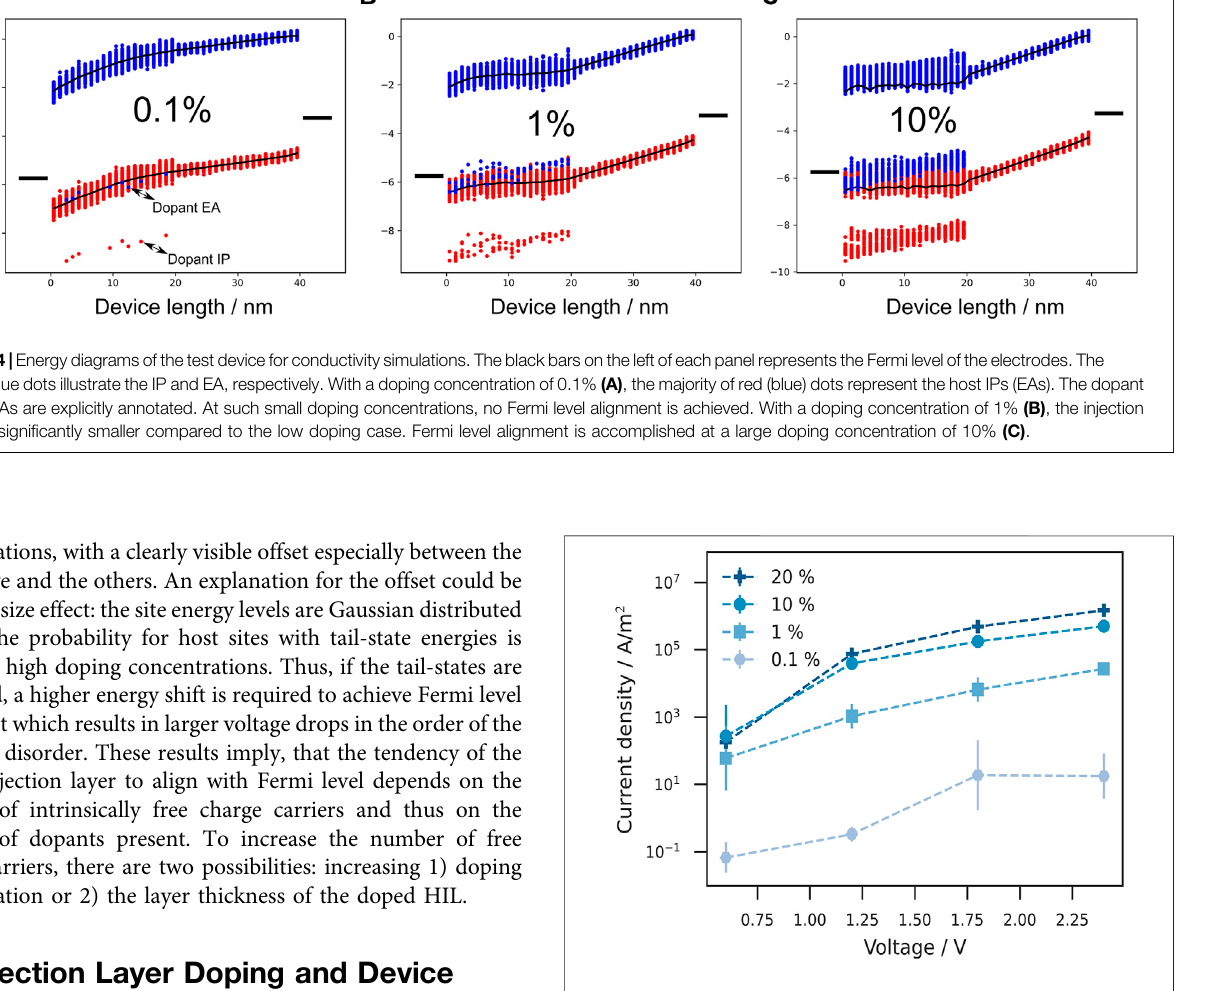
FIGURE 5 | Current voltage characteristics ( J – V -curve) at different doping concentrations. The current density is plotted against the applied voltage.Atalowdopingconcentration 0.1%thecurrentdensity issigni fi cantly smallerthanfor1%dopingconcentration.Higherdopingconcentrations (10%) lead to an further increase of the current density. The difference betweenthe10and20%JV-curvesisrelativelysmall,suggestingsaturationof the doping effect on the conductivity. The results here are in line with the energy diagrams in Figure 4